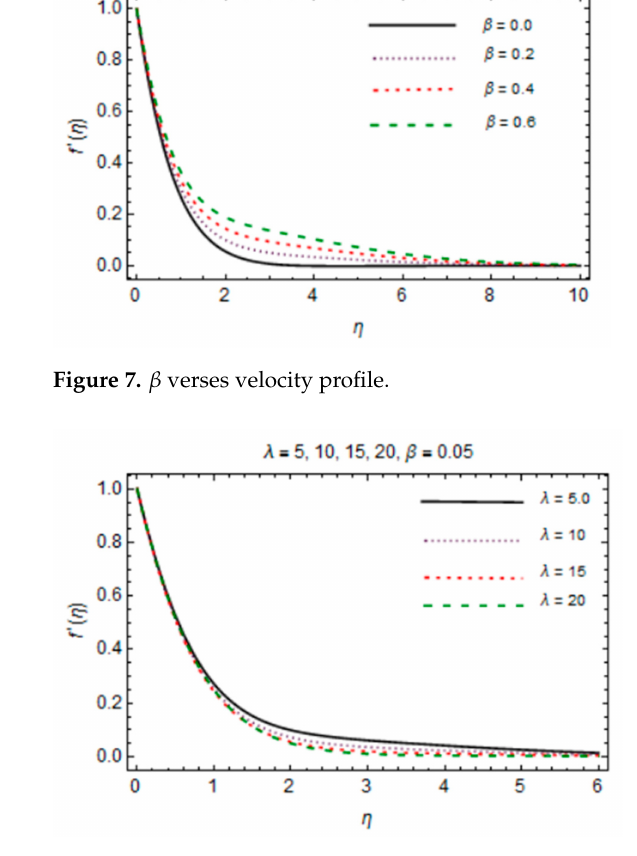
Figure 8. λ verses velocity profile.